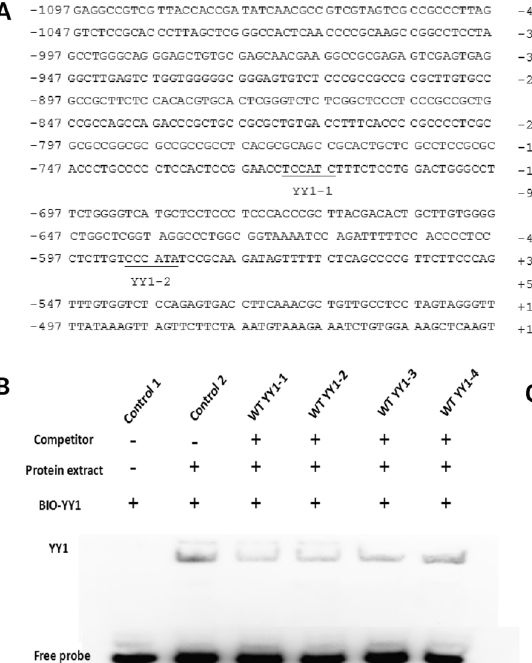
To further investigate whether YY1 transcriptionally regu- lates ATP6V1A , both HGC-27 and AGS GC cells were transferred with the constructed YY1 siRNA for knock- down and plasmid piRES2-EGFP-YY1 for overexpression, respectively. YY1-siRNA-NC and piRES2-EGFP were respectively used as a control. The mRNA and protein expression levels of ATP6V1A were assessed by qRT-PCR and Western blot assay, respectively. Our results showed that, following the transfection of YY1 siRNA into the HGC-27 gastric cancer cells, ATP6V1A mRNA and protein levels were significantly decreased (Fig. 4). In con- trast, the mRNA and protein expression levels of ATP6V1A were dramatically increased when these cells were transferred with the overexpression plasmid piRES2-EGFP-YY1. Similar results were also detected in the AGS gastric cancer cells (Fig. 4). Taken together, these results indicated that YY1 may play an important regulatory role in the transcription of ATP6V1A in gastric cancer cells. To further determine whether the expression of YY1 affects the increased activity of various ATP6V1A pro- moters with different lengths, overexpression plasmid piRES2-EGFP-YY1 were co-transfected into HGC27 GC cells with pGL3-basic-ATP6V1A-4, pGL3-basic-ATP6V1A-4-MU-1, pGL3-basic-ATP6V1A-4-MU-2, pGL3-basic-ATP6V1A-4-MU-3, and pGL3-basic, respectively. The activity of the promoter was examined 24 h after transfection. Compared with the negative control transfected with the plasmid pGL3-basic, the ATP6V1A promoter activity was significantly increased after transfected with plasmids pGL3-basic-ATP6V1A-4,